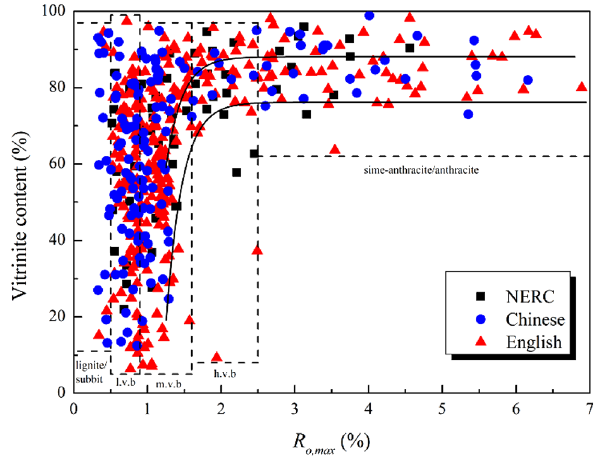
Fig. 9 Variation of vitrinite content with vitrinite reflectance R o ; max . (Data size: NERC-61, Chinese (Yu et al. 2004; Chang et al. 2006; Qin et al. 2007; Chang et al. 2008; Jiang et al. 2012; Lin et al. 2013; Xu and Pan 2015; Xiao et al. 2016)-159, English(Gan et al. 1972; Nelson et al. 1980; Giuliani et al. 1991; Crosdale et al. 1998; Marecka and Mianowski 1998; Bustin and Clarkson 1998; Laxminarayana and Crosdale 2002; Busch et al. 2003; Mastalerz et al. 2004; Hildenbrand et al. 2006; Busch et al. 2006; Siemons et al. 2007; Busch et al. 2007; Faiz et al. 2007a, b; Majewska and Zie˛tek 2007; Yu et al. 2008a, b, c; Astashov et al. 2008; Day et al. 2008; Mazumder and Wolf 2008; Pone et al. 2009; Majewska et al. 2009; Radlin´ski et al. 2009; Battistutta et al. 2010; Gensterblum et al. 2010; He et al. 2010; Kim et al. 2011; Day et al. 2011; Le Gal et al. 2012; Maphala and Wagner 2012; Sakurovs 2012; An et al. 2013; Cai et al. 2013a, b; Dutka et al.